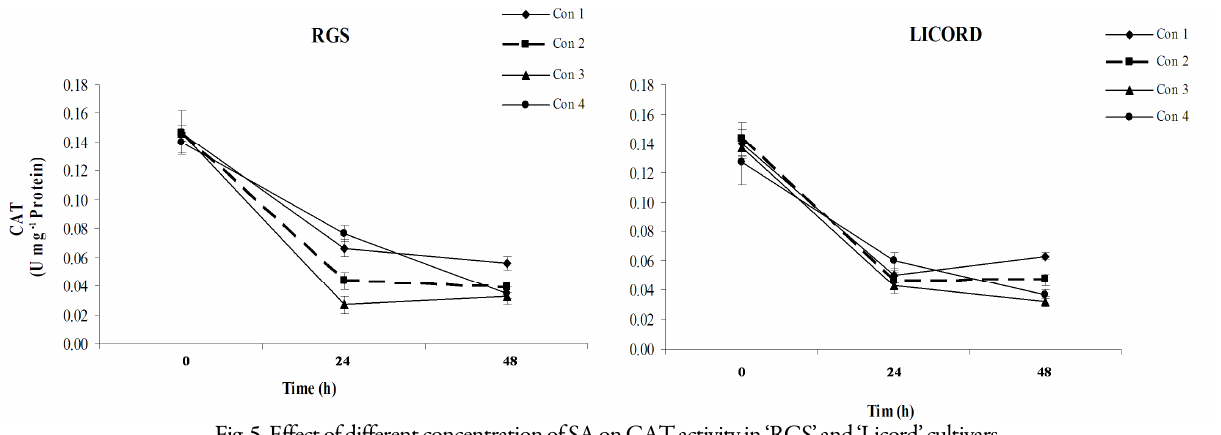
Fig. 5. Effect of different concentration of SA on CAT activity in ‘RGS’ and ‘Licord’ cultivars